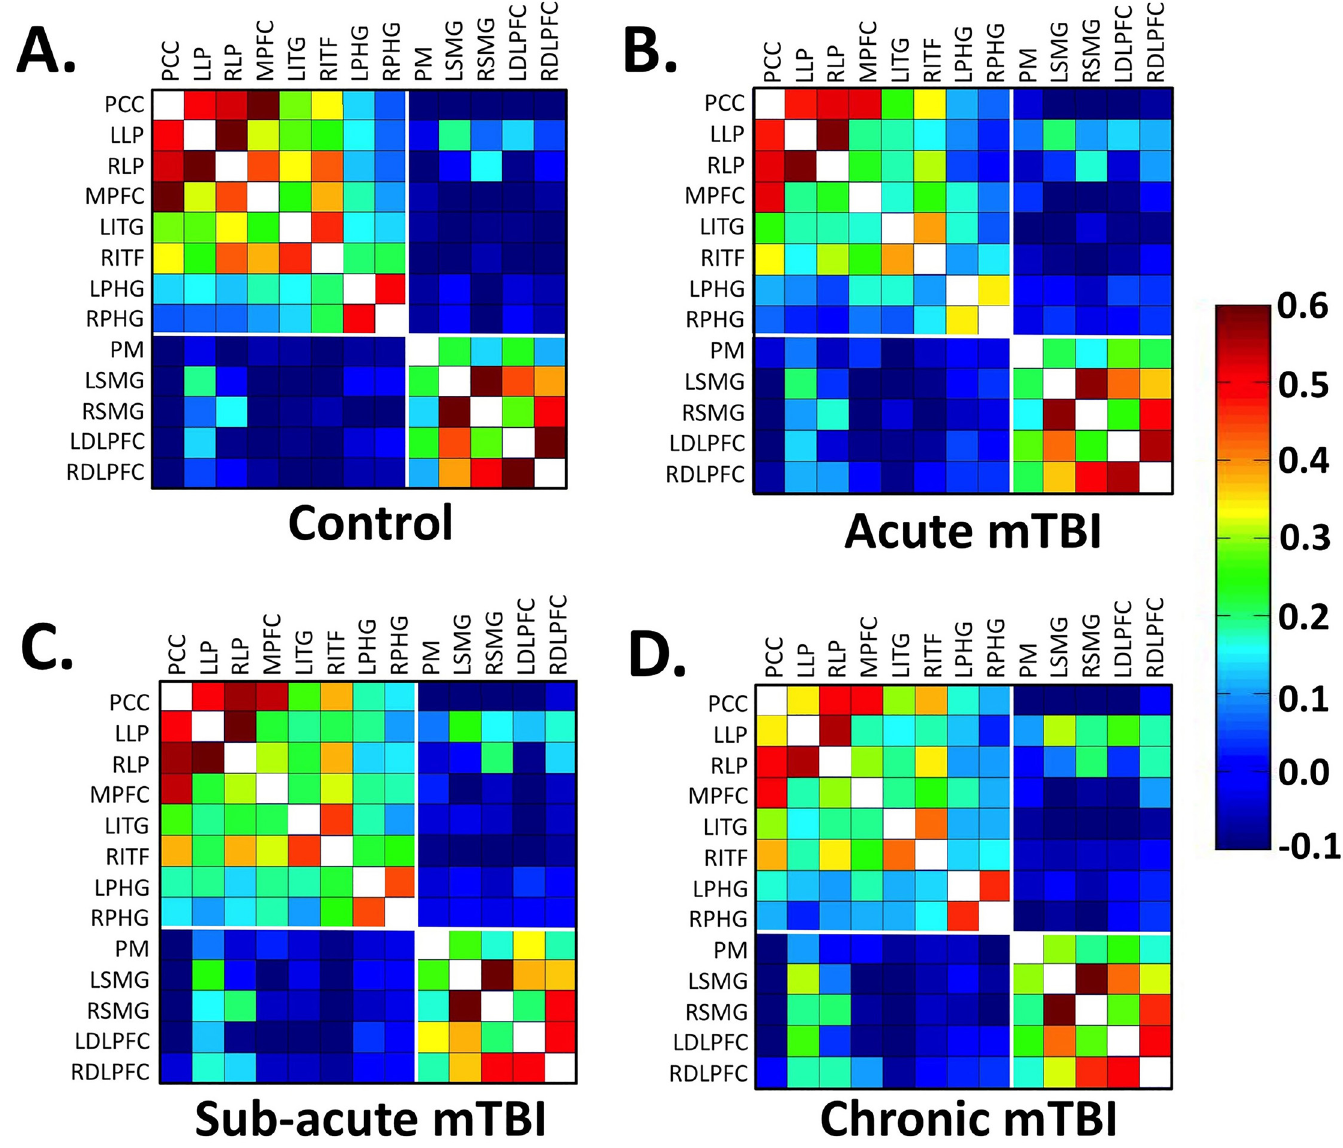
Fig 4. Average correlation matrices. Matrices illustrating both within and between network connectivity values for the DMN and TNP for (A) Controls (B) Acute mTBI (C) Sub-acute mTBI (D) Chronic mTBI. The white boundaries separate the Default Mode Network (DMN) and the Task Positive Network (TPN) regions of interest (from top of matrix to bottom of matrix respectively). The color bar represents z-scores.